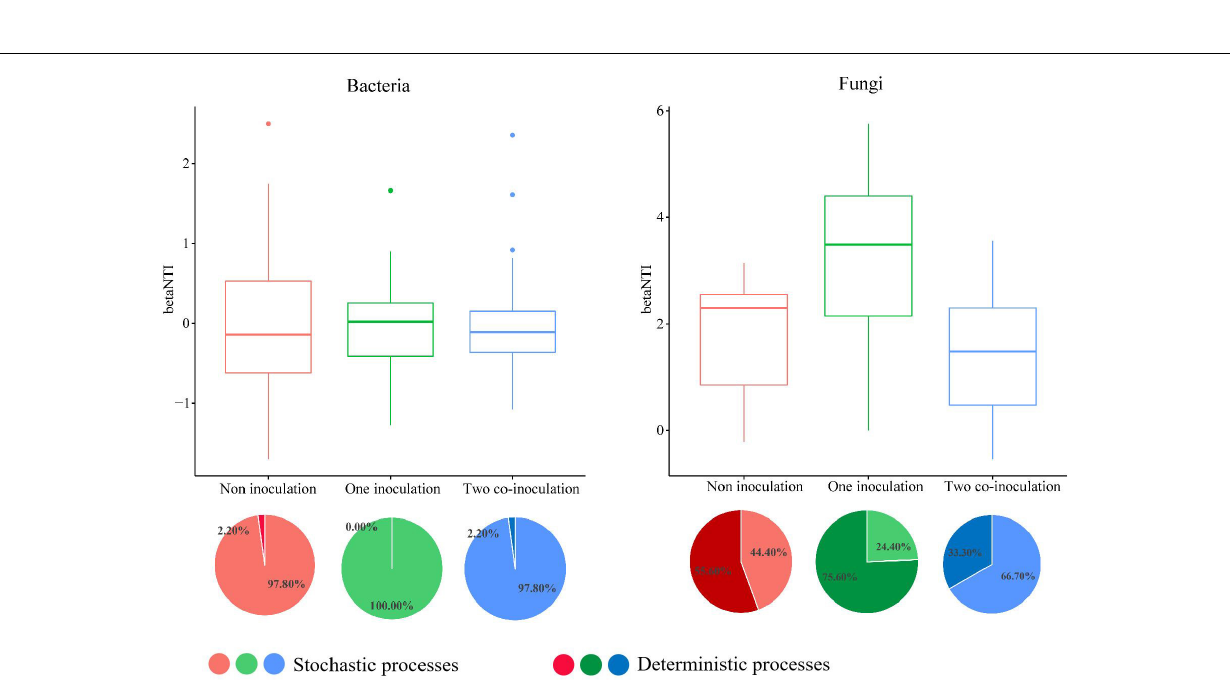
Frontiers in Microbiology |